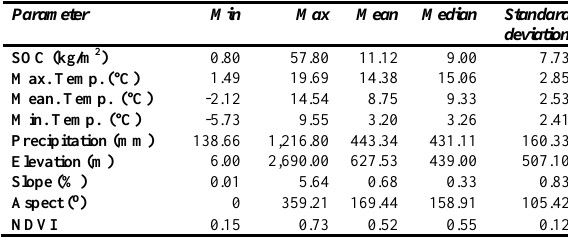
Figure 3. (a) Sub-workflow of regression model selection process, and (b) illustration of spatial processes described by spatial error and lag models (Source: Anselin,